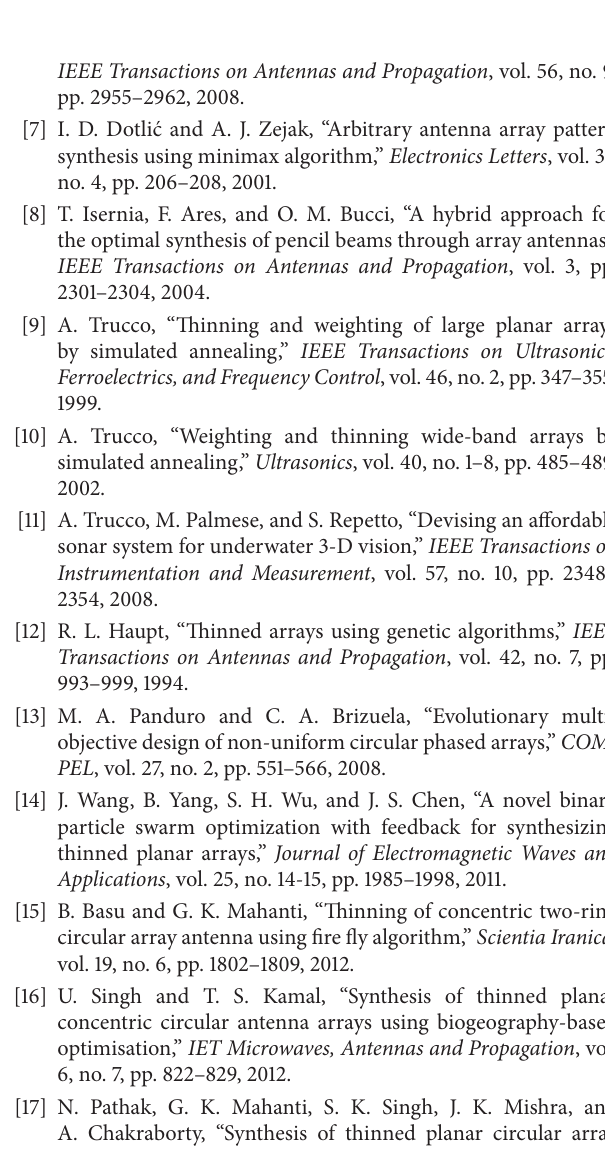
Figure 9: Nonuniform CCAA optimized by MTLBO for SLL reduction in adequately extended space. (a) Configuration of a 189-element uniform array and (b) the related array factor with SLL = − 18.13dB and FNBW =